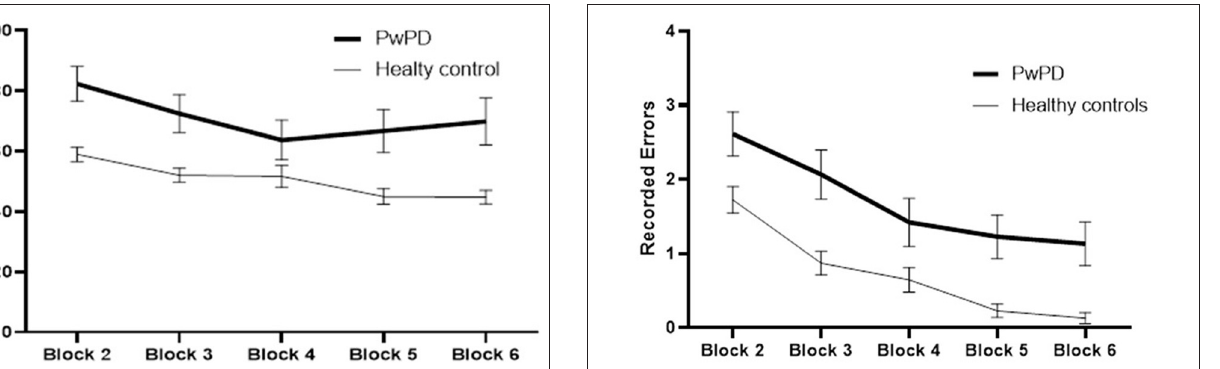
The results indicate significant performance changes between blocks 2 and block 6 in healthy controls and PwPD in both outcome measures. Table 3 summarizes the relationship between motor skill acquisition, sleep quality measures, and plasma serotonin in PwPD and healthy controls. In healthy controls, there was significant correlation between motor skill acquisition (as indicated by the difference of time required to complete